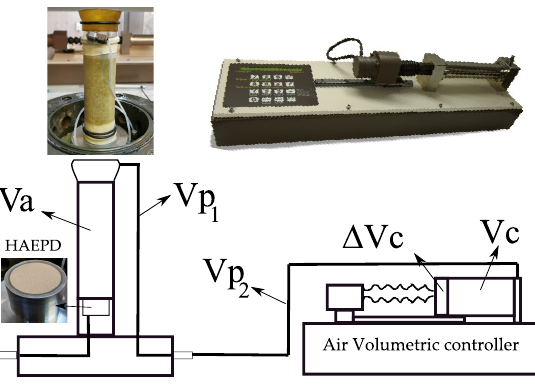
Figure 9. Designations of different air volumes.